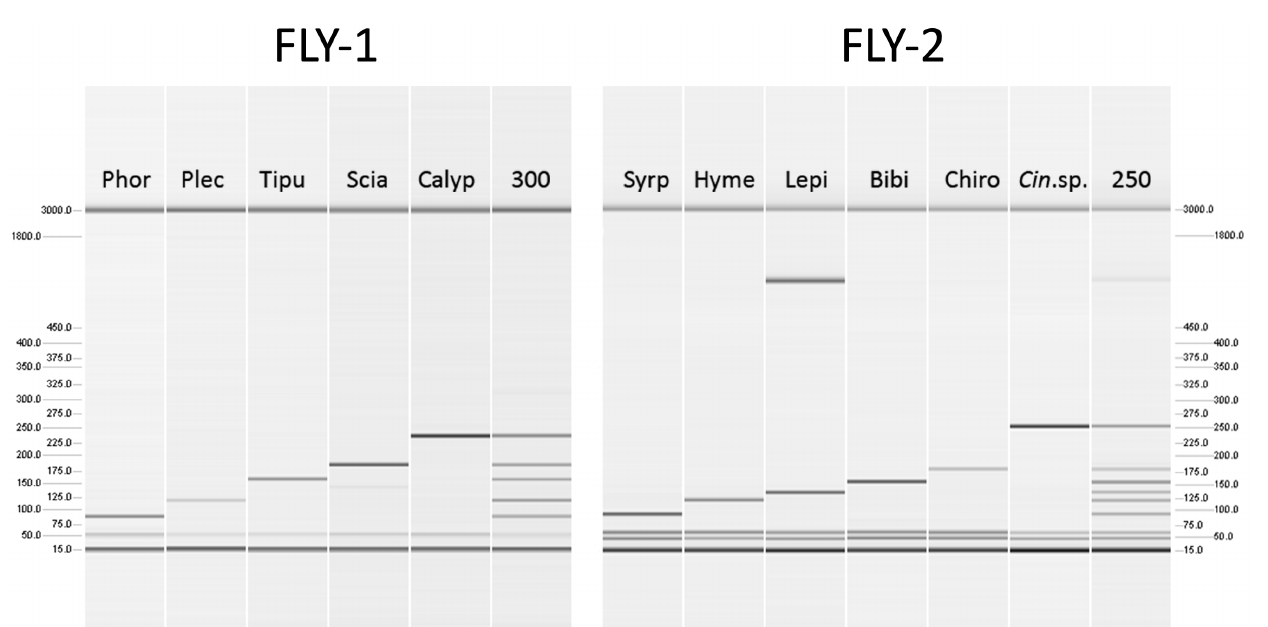
Fig. 1. Gel image of PCR products amplified with the multiplex PCR systems FLY-1 and FLY-2 and separated with QIAxcel. FLY-1: Phoridae (Phor), Plecoptera (Plec), Tipulidae (Tipu), Sciaridae (Scia), Calyptratae (Calyp), artificial mix containing 300 double stranded (ds) templates per target. FLY-2: Syrphidae (Syrp), Hymenoptera (Hyme), Lepidoptera (Lepi), Bibionidae (Bibi), Chironomidae (Chiro), Cinara sp. (Cin.sp.), artificial mix with 250 ds templates per target. Note that an internal marker is run alongside each sample (15 and 3000 bp) and the scale on the left and right side, respectively, allows an estimation of fragment length. Sciaride may result in an additional weaker amplicon of , 140 bp which is not interfering with another fragment in the system; the same applies for the long fragment that can be amplified from lepidopterans.